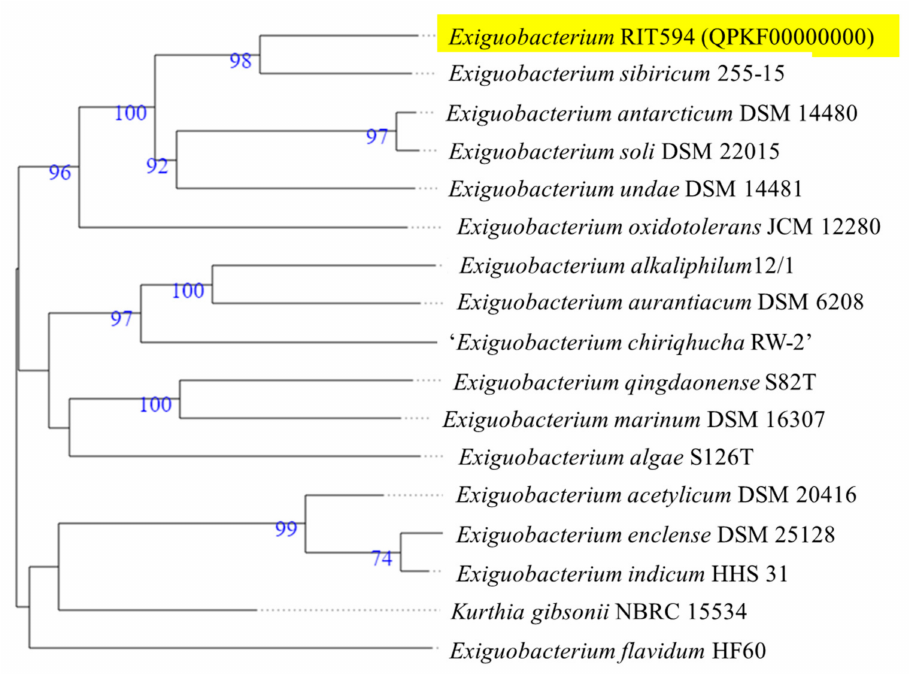
Figure 1. Whole genome-based phylogeny of the Exiguobacterium sp. RIT 594 isolate predicted by TYGS (see earlier references) shows the closest relative to be Exiguobacterium sibiricum 255-15. TYGS analysis is based on Genome BLAST Distance Phylogeny (GBDP) with distances calculated from the genome sequences. Branch lengths are scaled in terms of GBDP distance formula and the numbers above the branches are GBDP pseudo-bootstrap support values from 100